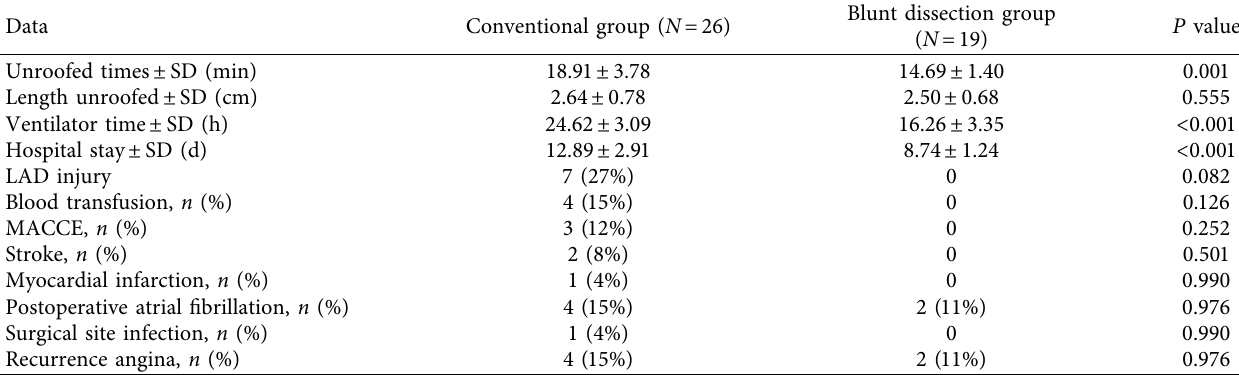
Table 2: Surgical and postoperative characteristics of the patients in both the